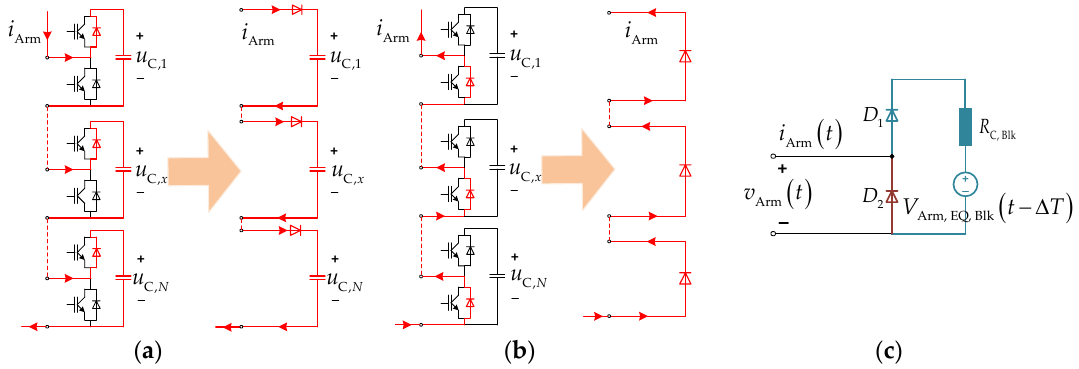
Figure 7. The Thévenin equivalent process in the blocked state: ( a ) The positive direction of the current; ( b ) The negative direction of the current; ( c ) Thévenin equivalent circuit of the arm in the blocked state.